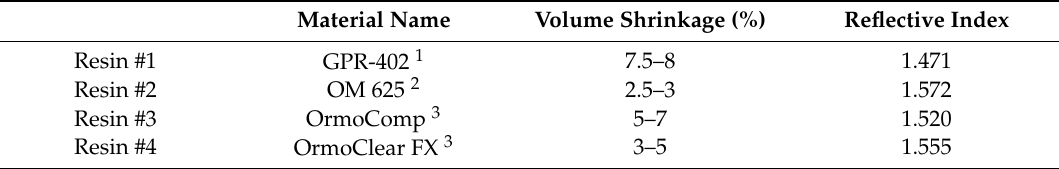
Table 2. Resins used for final imprinted